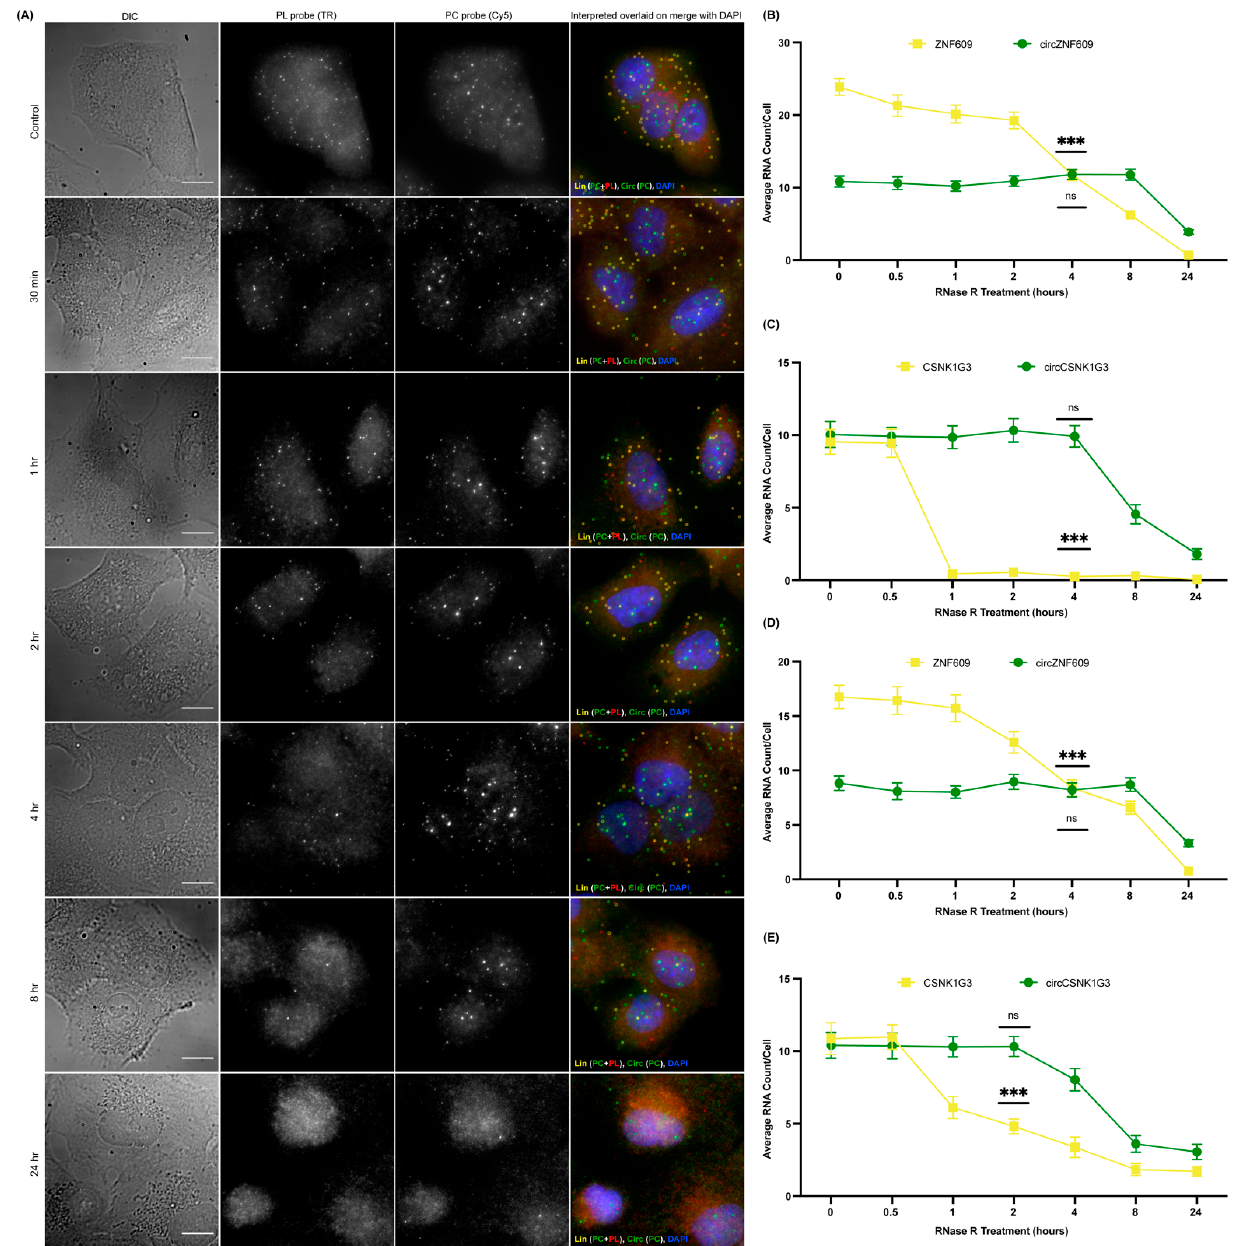
Figure 2. Optimization of in situ RNase R treatment for circFISH. ( A ) Representative image panel of A549 cells after 0 min, 30 min, 1 h, 2 h, 4 h, 8 h, and 24 h treatment (from top to bottom) with RNase R before hybridization with PL and PC ZNF609 probes. Columns from the left: DIC; raw merged z stacks of cells for PL probes labeled with TR; raw merged z stacks of cells for PC probes labeled with Cy5; and a merged image of the two channels with TR spots pseudo-colored red and Cy5 pseudo-colored green, overlaid on DAPI, with MATLAB-interpreted spots showing linear RNA as yellow and circular RNA as green. ( B – E ) Quantification of the average ZNF609, circZNF609, CSNK1G3, and circCSNK1G3 RNA molecules per cell after MATLAB analysis at each RNase R timepoint in the A549 ( B , C ) and DLD-1 ( D , E ) cells, respectively. The error bars indicate the 95% confidence interval for at least 100 cells. *** Indicates a significant difference between 0 mins and the particular timepoint, with a p -value < 0.001, and ns indicates no significant difference. The scale bar is 5 μ m.